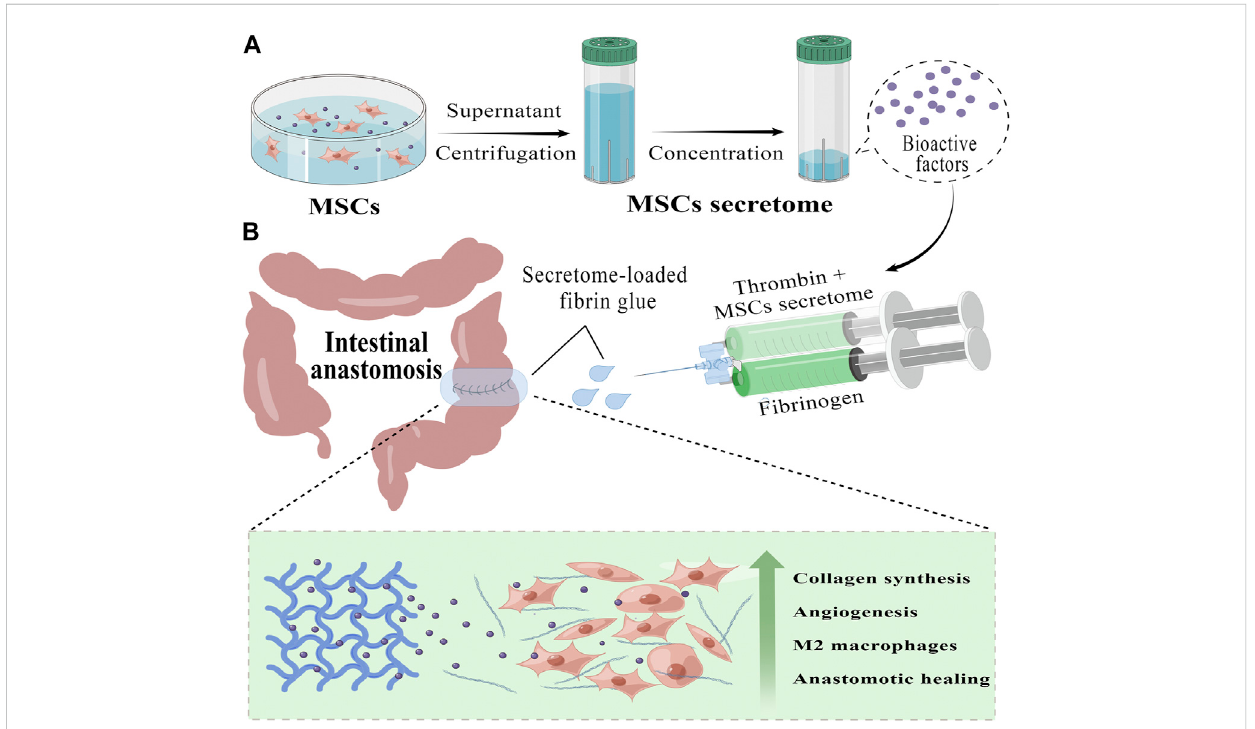
FIGURE 1 Preparation and application of MSCs secretome-loaded fi brin glue (by Figdraw). (A) We collect the secretome from the conditioned medium of human umbilical cord mesenchymal stem cells (hucMSCs) and further concentrate it into different secretome concentrates with protein ultra fi ltration tubs, which contain a variety of bioactive factors that promote tissue repair. (B) Using a convenient mixed injection, we can rapidly form an MSCs secretome-loaded fi brin glue (Secretome/FG) patch covering the surgical anastomosis tightly. By slowly releasing bioactive factors,